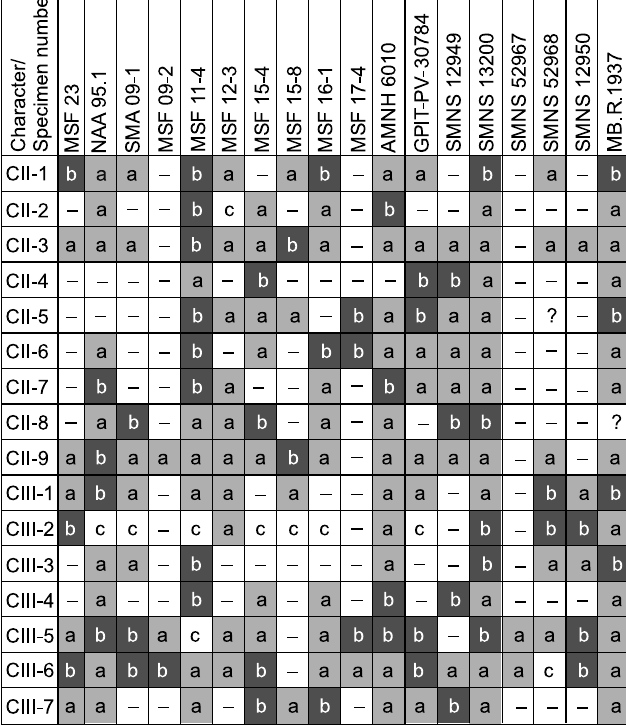
Fig. 15. Overview over the distribution of variable features occurring in two or more skulls (category II and III characters; CII and CIII, respec - tively) in the 18 most complete skulls of Plateosaurus examined herein. The prevalent character state is marked with “a”, while the rarer state is marked with “b”. Intermediate states are marked with “c”. No correlations of feature combinations that might indicate distinct species are evident, and the observed pattern is consistent with intraspecific